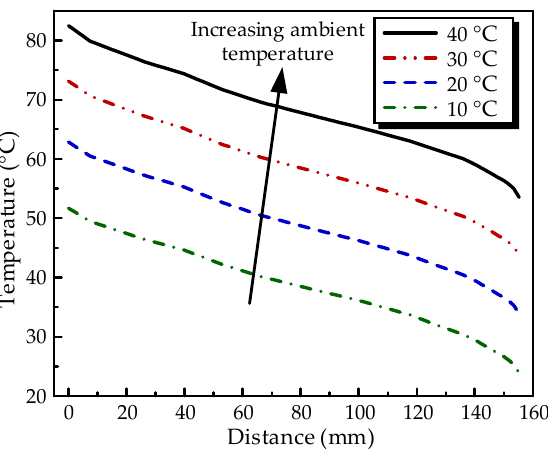
Figure 12. Surface temperature distribution along the spacer surface with different ambient temperatures.